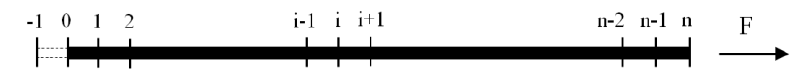
Figure 4. Finite difference discretization of the FRP-to-concrete